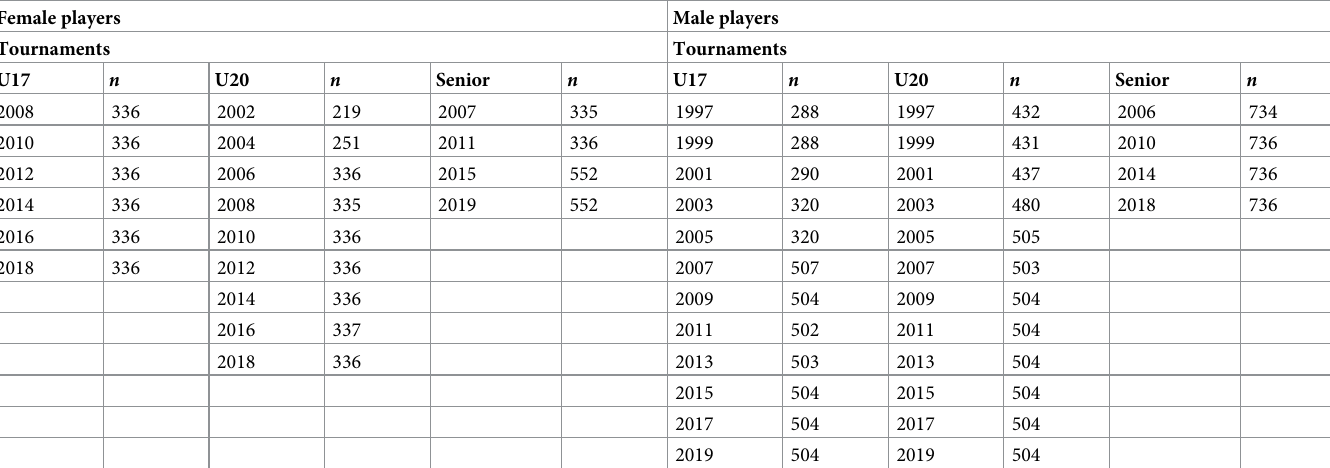
Table 1. Main characteristics of the total